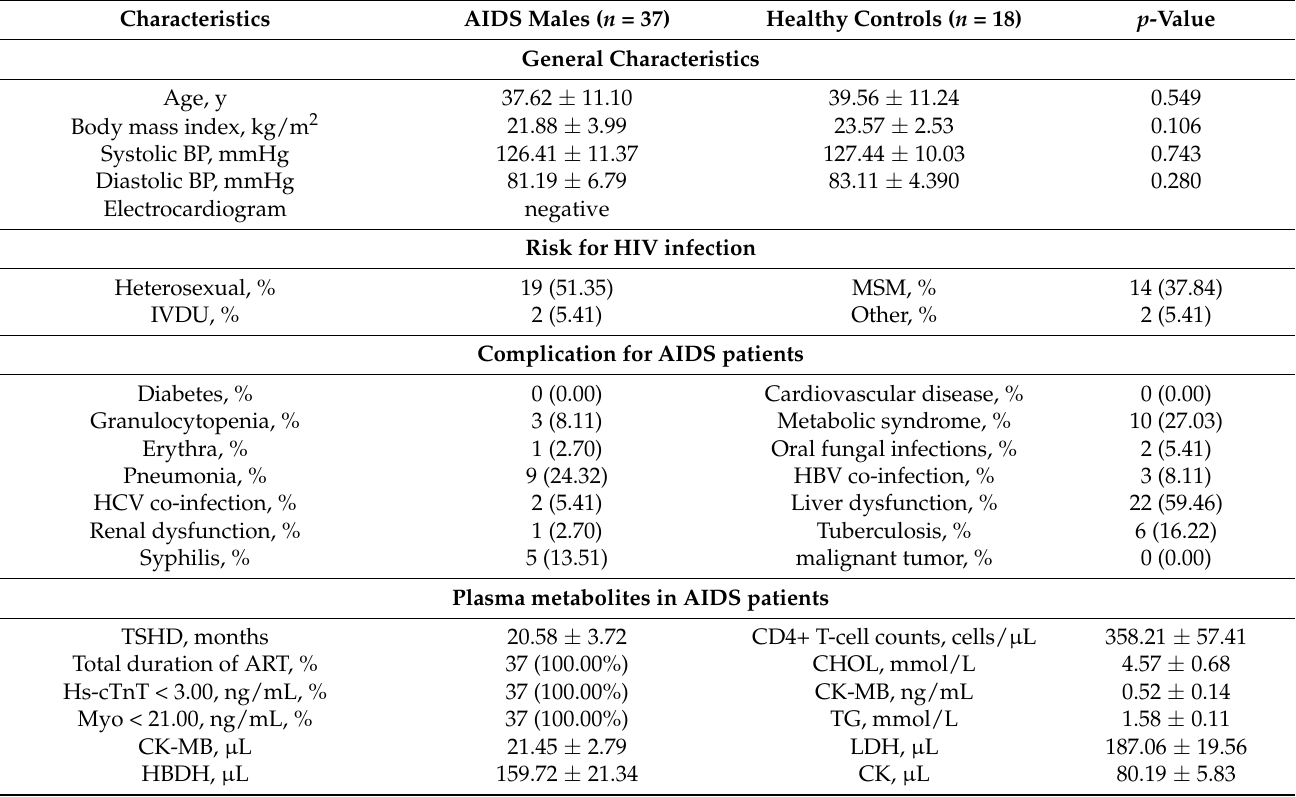
Table 1. Baseline characteristics.